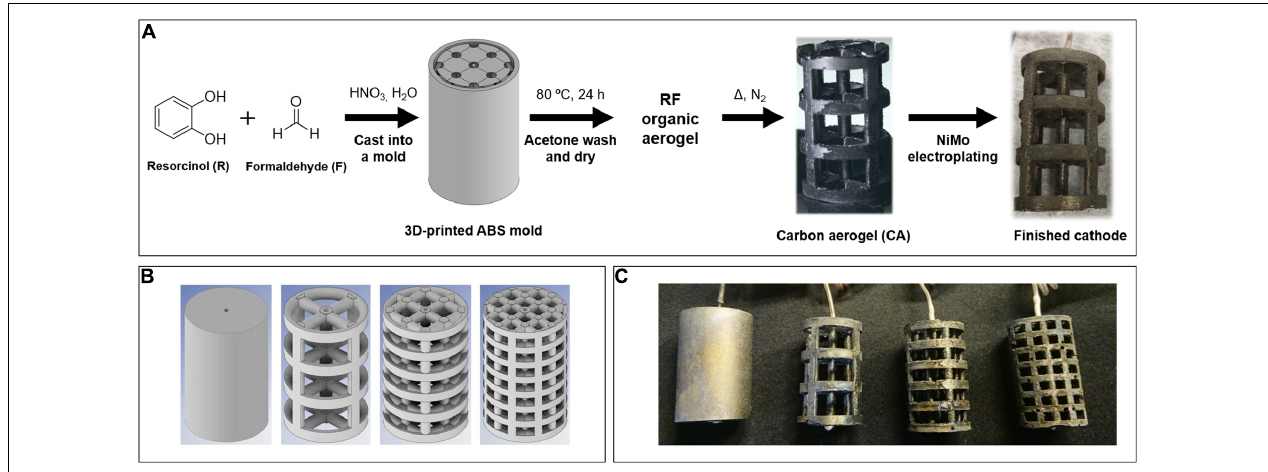
FIGURE 1 | Additive manufacturing process of the NiMo-plated carbon aerogel cathodes (A) . Visualization of computational models of inversed ABS molds for 3D-printing (B) and photograph of one set of finished NiMo-plated carbon aerogel cathodes of varying surface areas (C) . The geometric surface areas of the different cathodes are from left to right 39, 55, 86, and 111 cm 2